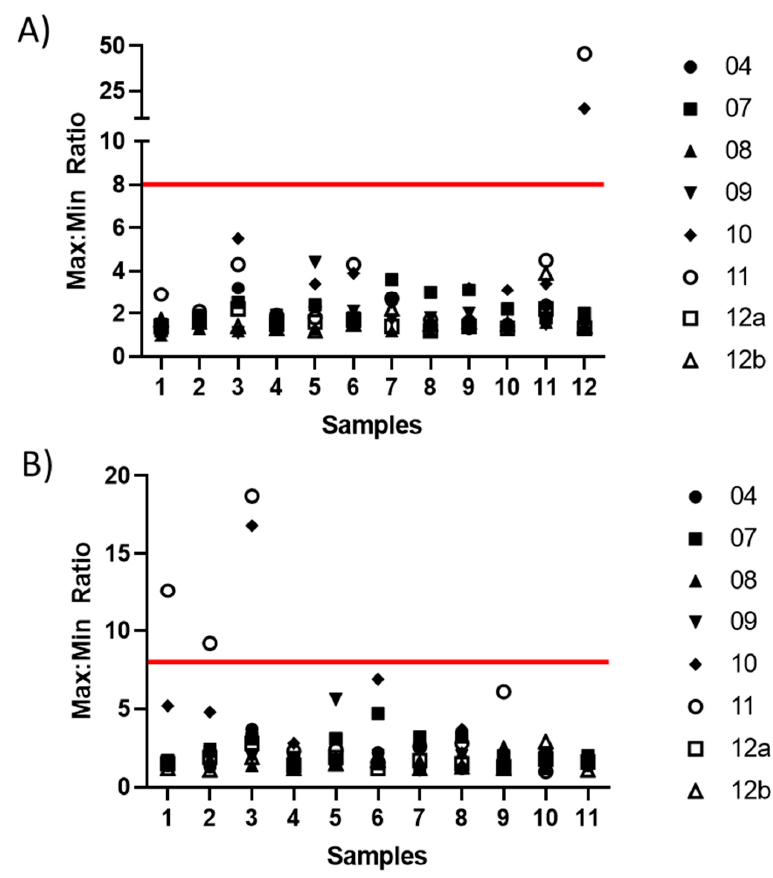
Figure 6. Intra-laboratory variability in ED50 and relative potency estimates. Individual points show the max:min ratio of laboratory ED50 estimates ( A ) and relative potency estimates ( B ) for each sample and laboratory; the red line marks a max:min ratio of 8-fold. Table 4. Geometric mean endpoint readout estimates—Virus Neutralization assays.